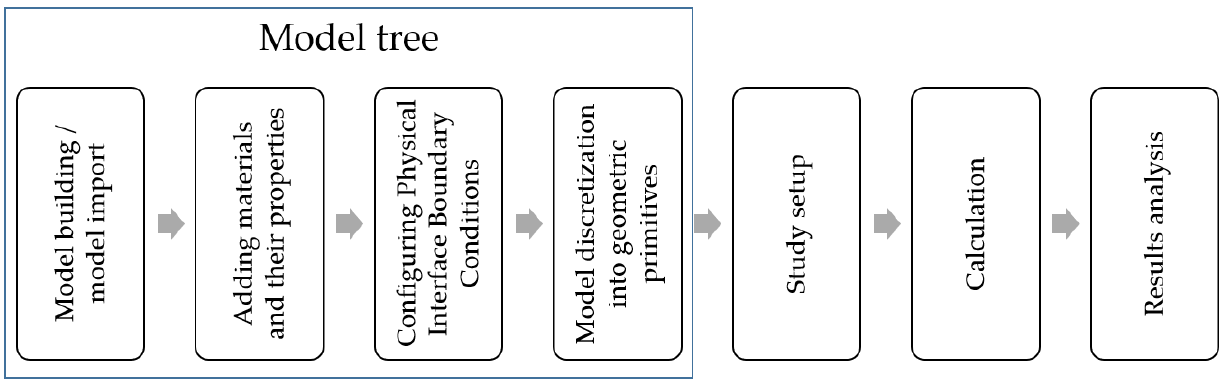
Figure 4. Research algorithm in COMSOL Multiphysics 5.4.